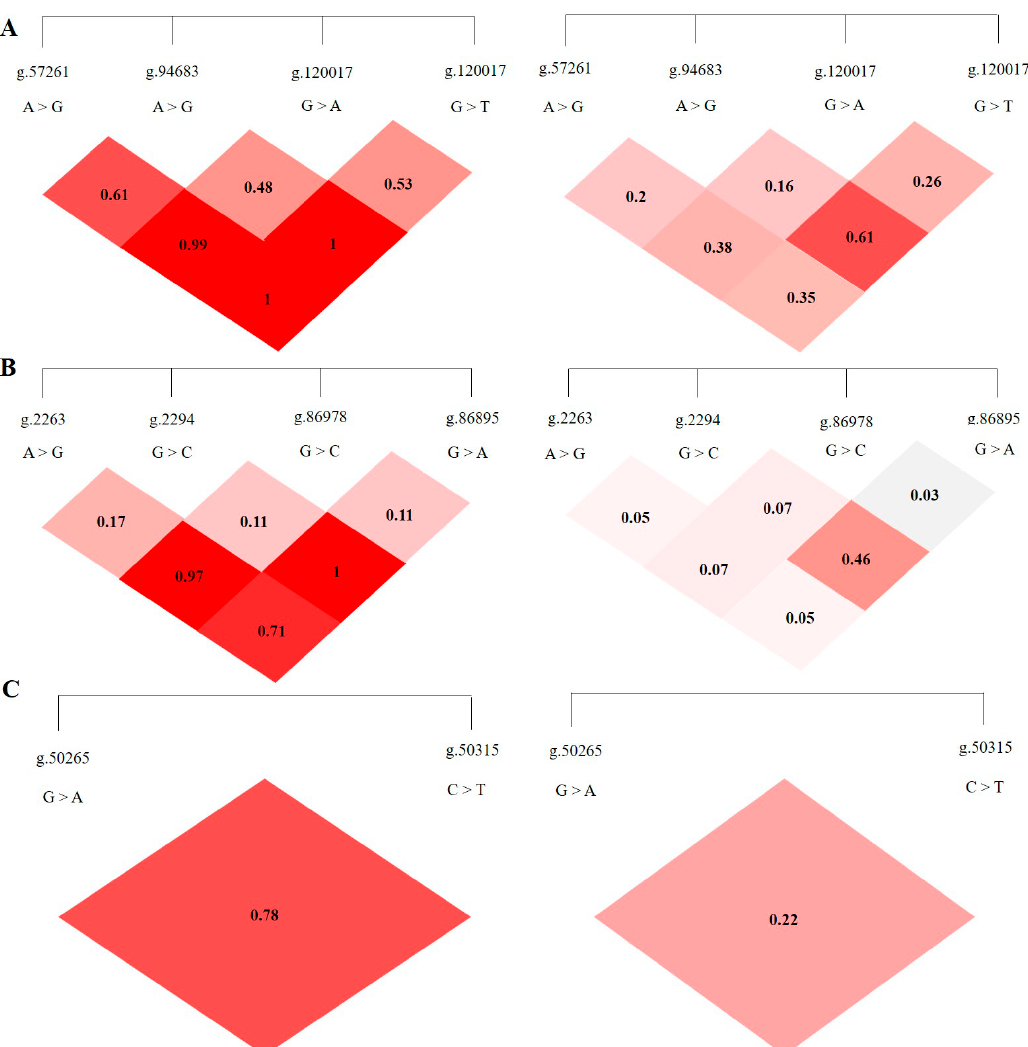
Figure 5. The linkage map of SNPs loci of ABCG2 , CD44 , SPP1 genes. LD value D ′ > 0.7, r 2 > 1/3 indicates relatively high linkage strength. ( A ) The LD map of 4 SNPs loci of ABCG2 gene. ( B ) The LD map of 4 SNPs loci of CD44 gene. ( C ) The LD map of 2 SNPs loci of SPP1 gene. 3.4. Genotype Frequency and Allele Frequency of SNP Loci in ABCG2, CD44 and SPP1